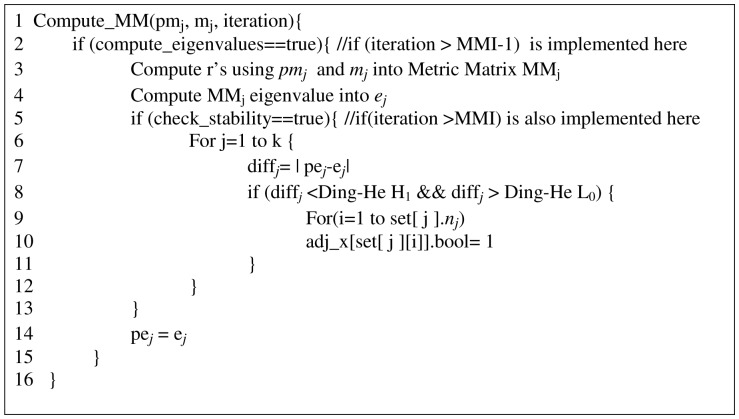
Pseudocode of our Compute_MM Sub-program for MMk-means.We create a covariance matrix, computing the Pearson product moment correlation coefficient between the k centroids of the previous and current iterations and then deduce k previous and current iterations eigenvalues. The difference of these eigenvalues for each cluster is computed and checked to see if it satisfies the Ding-He interval.